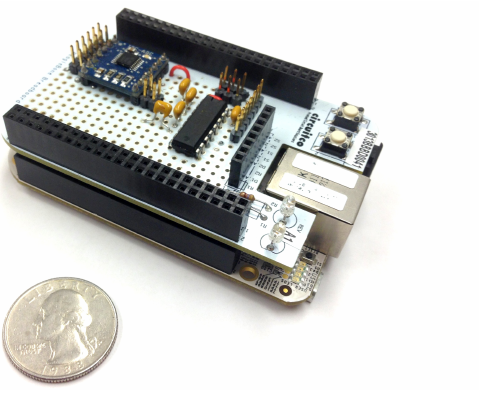
Figure 3. The developed high-frequency sensor data acquisition system